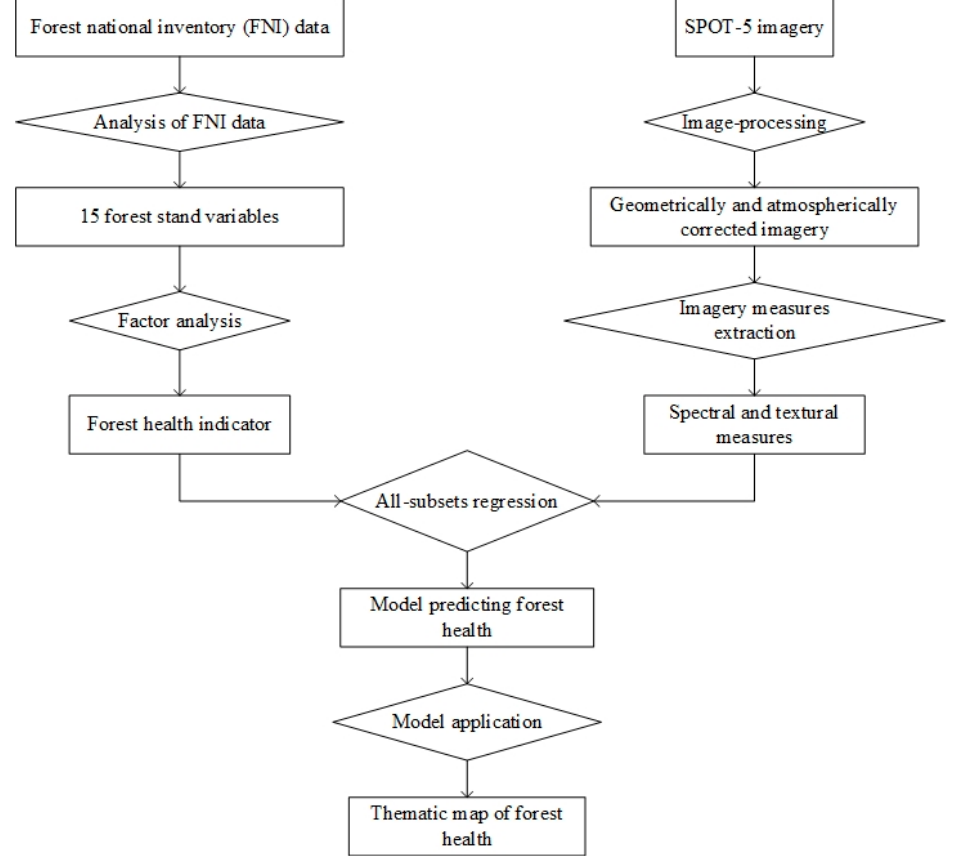
Figure 2. A flow chart of the forest health indicator derivation, imagery measures extraction, prediction model development and forest health mapping.